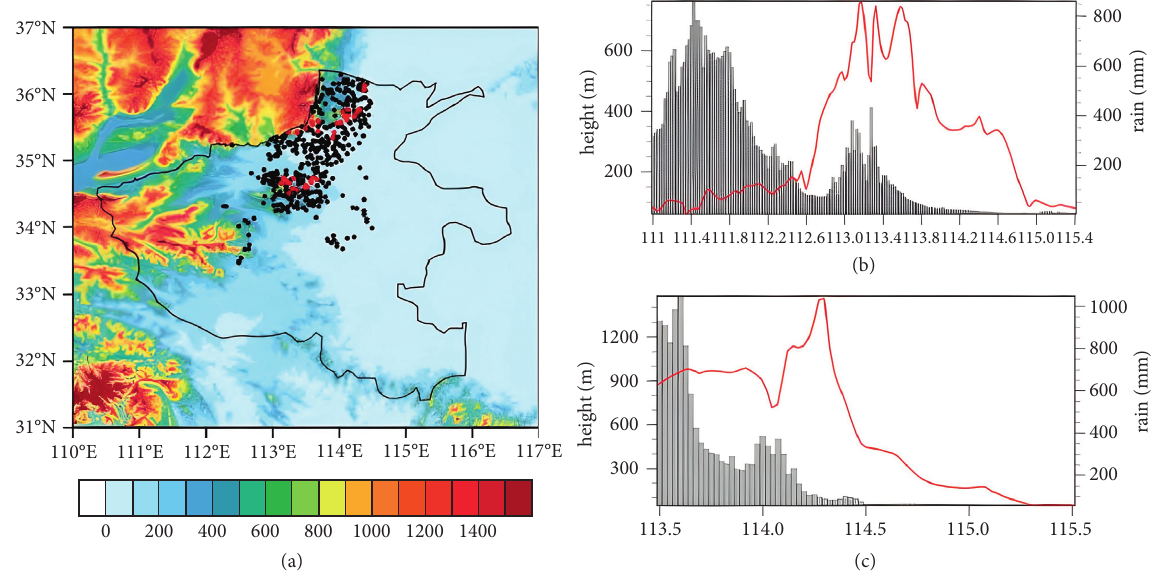
Figure 4: The heavy rainstorm from 08:00 on 17th of July to 08:00 on 23rd of July, 2021, in Zhengzhou, China. (a) The site distribution of process accumulated rainfall larger than 400mm and less than 800 mm (black dots) and larger than 800mm (red dots) (filled color represents altitude, units: m). (b) The variation curves of altitude (columnar shadow) and process accumulated rainfall over the Zhengzhou station 34.7 ° N and (c) the station 35.77 ° N